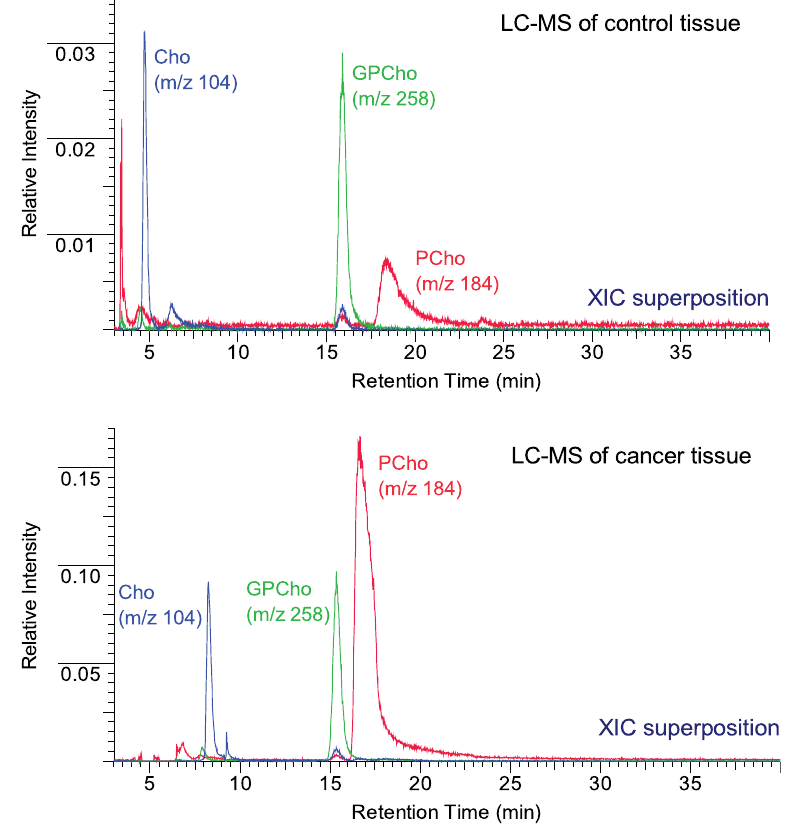
Fig. 4. Examples of LC/ESI-MS analysis of aqueous extracts derived from healthy breast tissue (top panel, sample C-5) and cancerous breast tissue (bottom panel, sample C-6). Only the extracted ion chromatograms (XICs) are shown for Cho (blue traces), PCho (red traces), GPCho (green traces). The Cho and PCho components occurring at the retention time of GPCho (at 15-16 min) are due to in-source fragmentation of the latter metabolite. The splitting of the Cho peak into two peaks is likely to be ascribed to the different possible mechanisms of interactions of the molecule with the HILIC solid phase at the operating conditions. A remarkable difference in the relative intensity of Cho, PCho and GPCho signals is found and is consistent with cancer-related metabolism